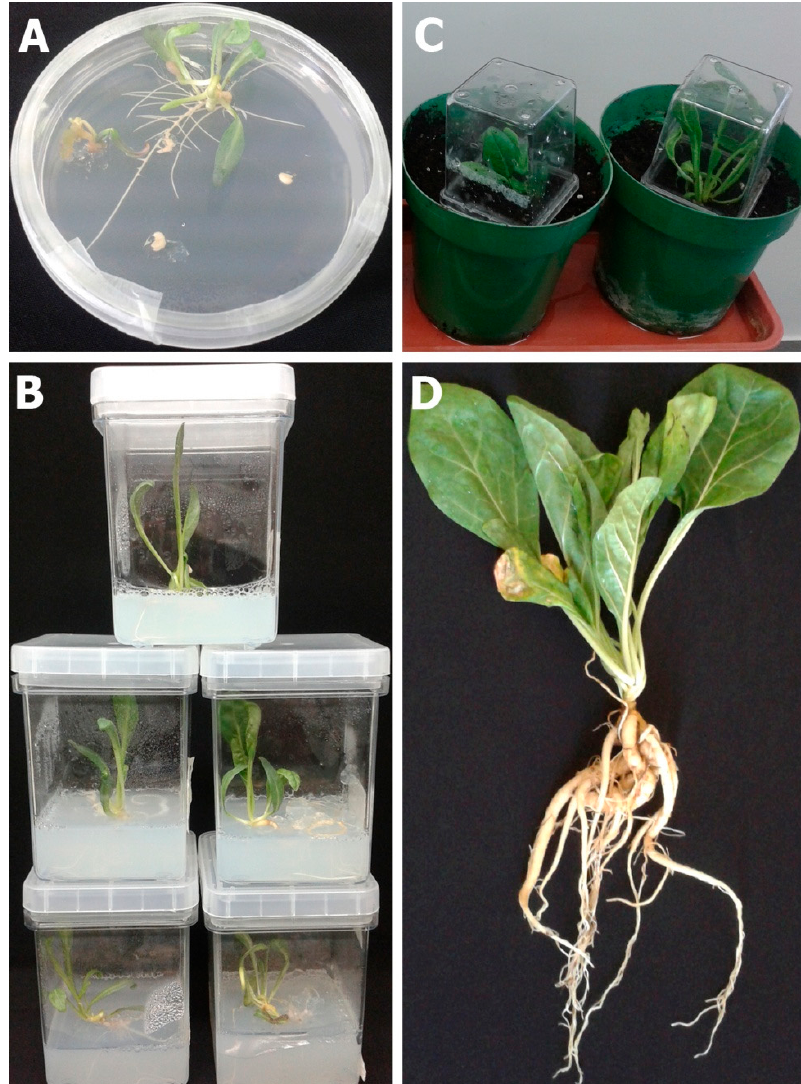
Figure 6. Development of healthy M. autumnalis plants through in vitro seed germination. ( A ) Representative normal seedling emerged from decoated seed cultured on SGM included 30 mg/L GA 3 ; ( B ) representative emerged seedlings transferred to Magenta ® jars containing 1X MSO medium to continue normal growth; ( C ) transplanted plantlets were grown in soil under the glasshouse conditions to reach maturity ( D ).